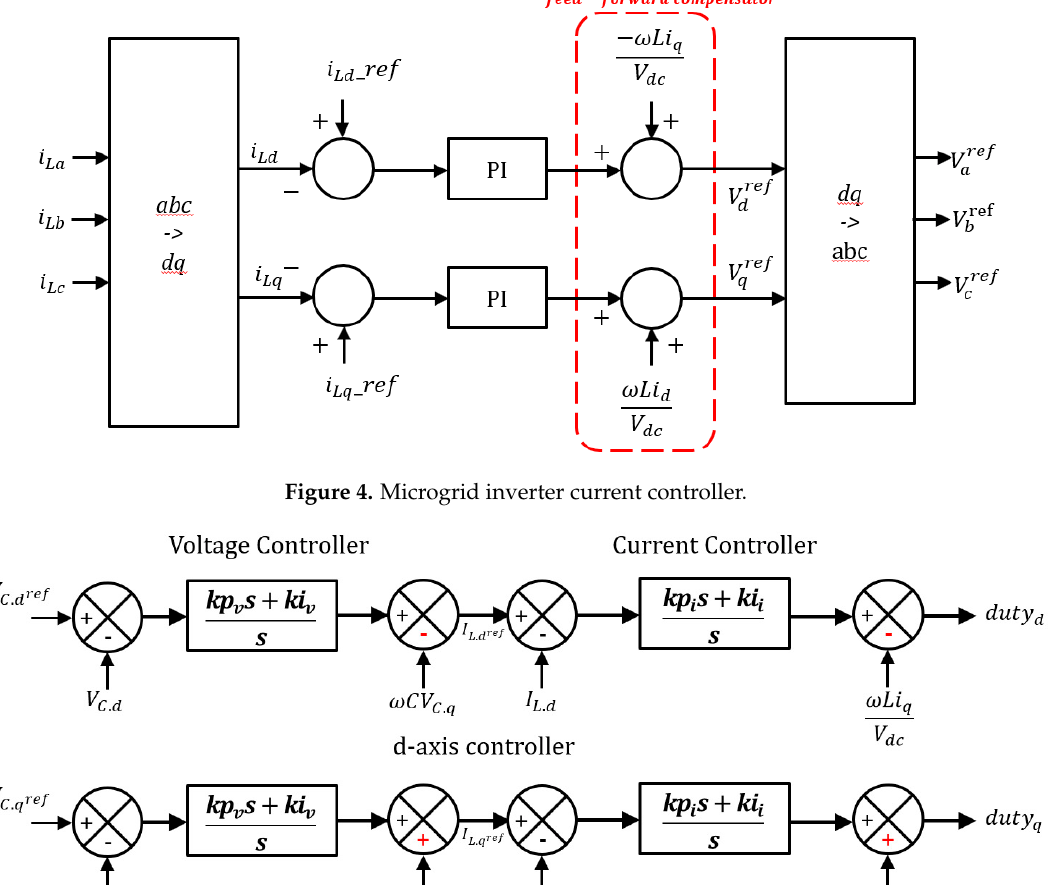
Figure 4. Microgrid inverter current controller.